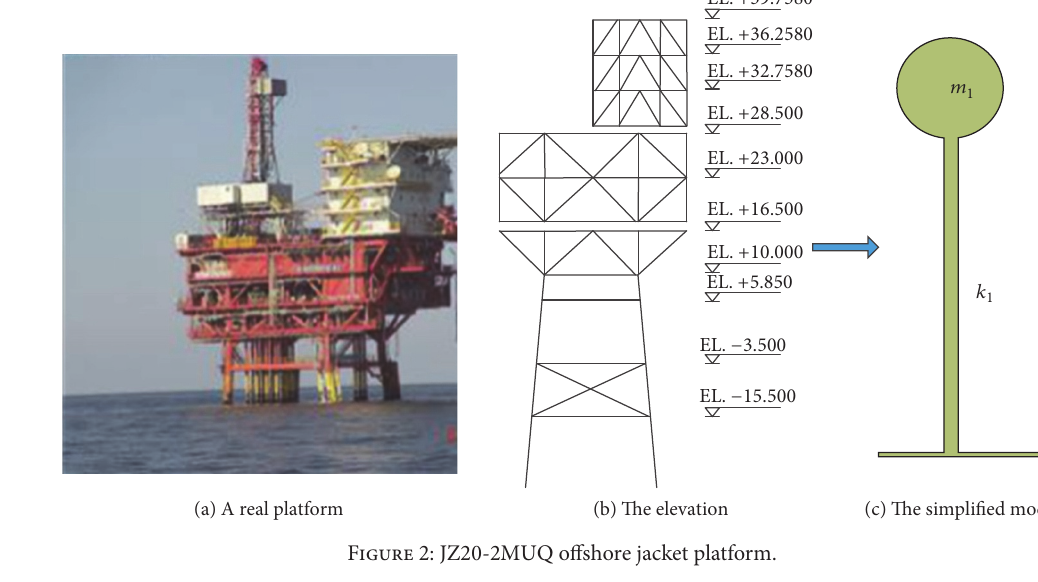
Figure 2: JZ20-2MUQ offshore jacket platform.